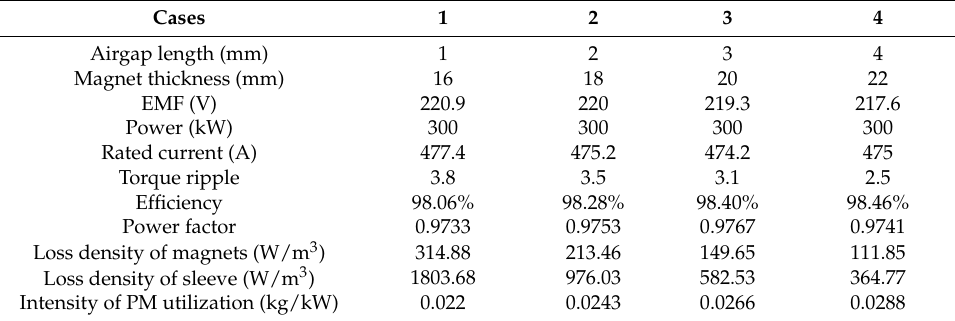
Table 2. Electromagnetic performance of the prototype with different airgap